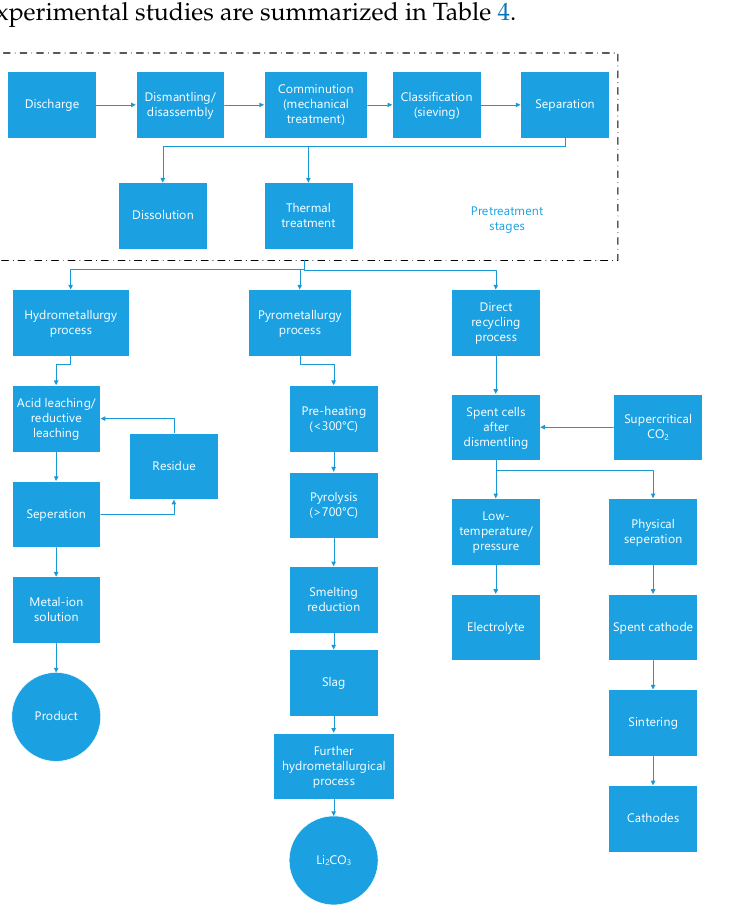
Figure 7. Pre-treatment and various recycling processes of waste LIBs (partially adopted from Kim, et al. [104] and Zhou, et al.